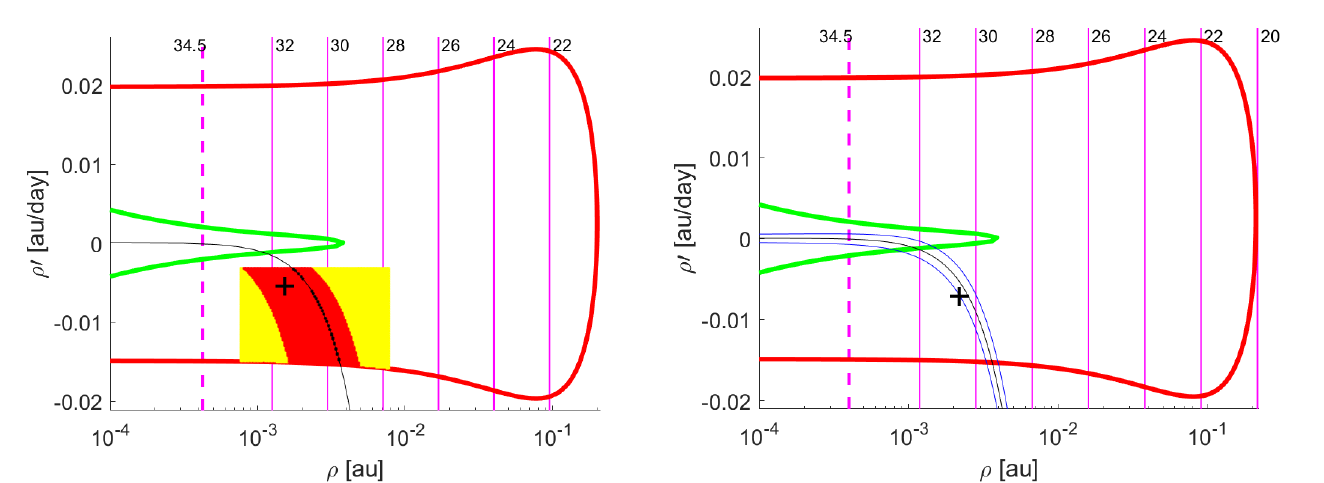
Figure 5. Fit (black curve) and uncertainty (blue curves) of the MOID = 0 line for 2018LA.